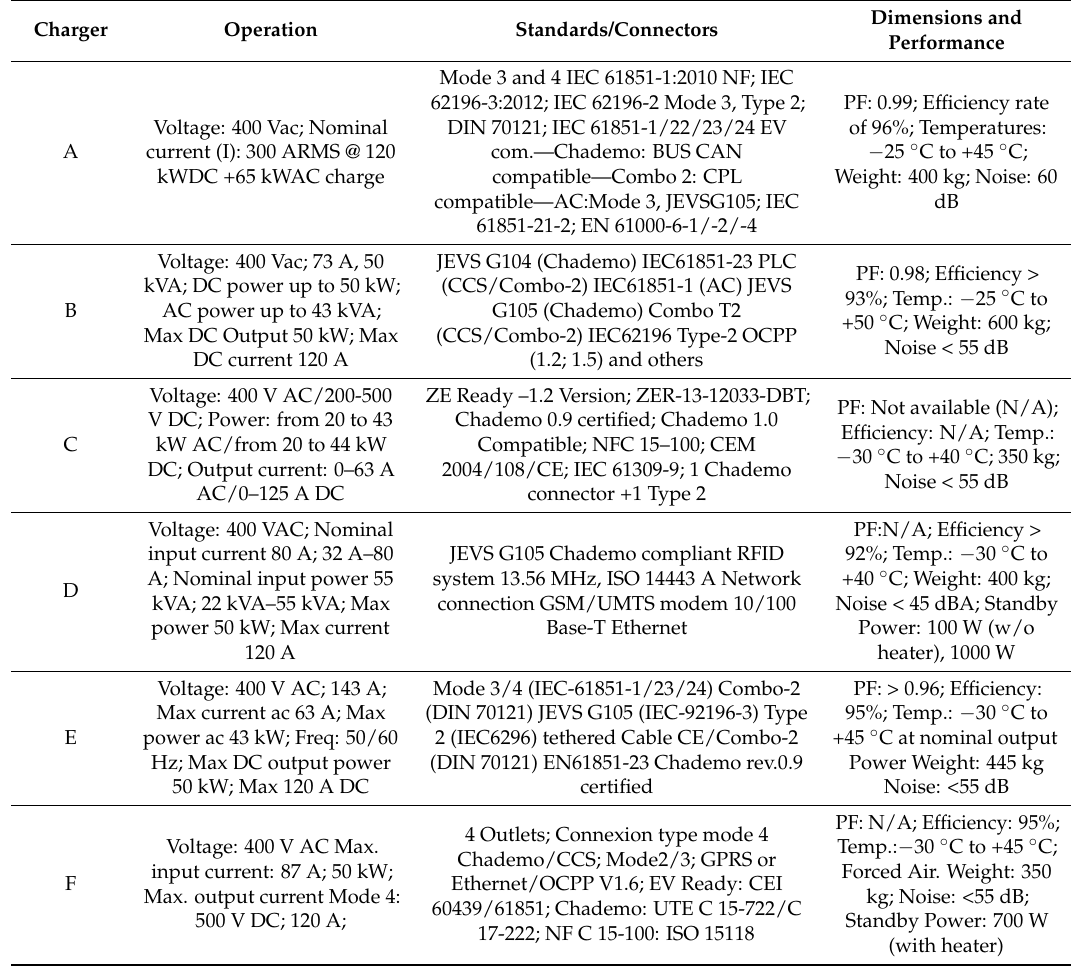
Table 2. The main characteristics of the